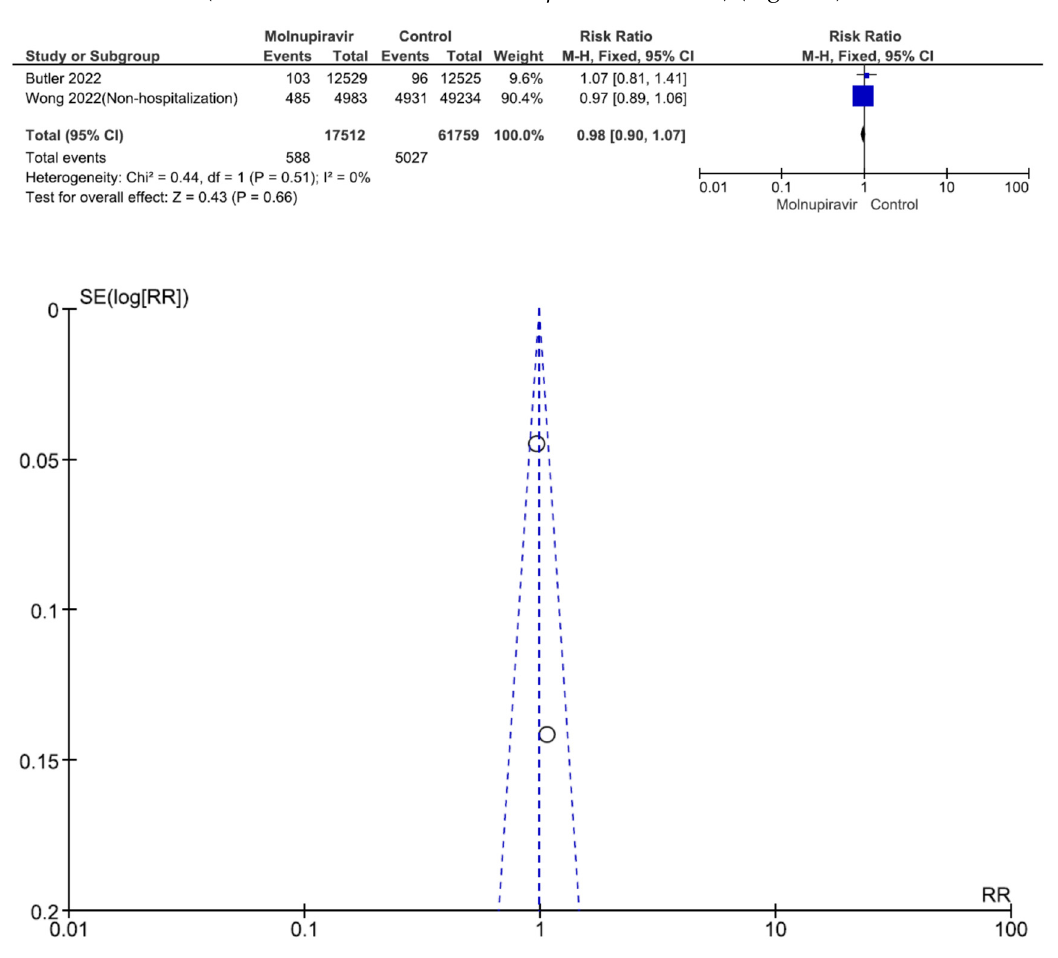
Figure 7. Hospitalization between molnupiravir and placebo in the treatment of mild to moderate COVID-19 in adult patients [26,31].